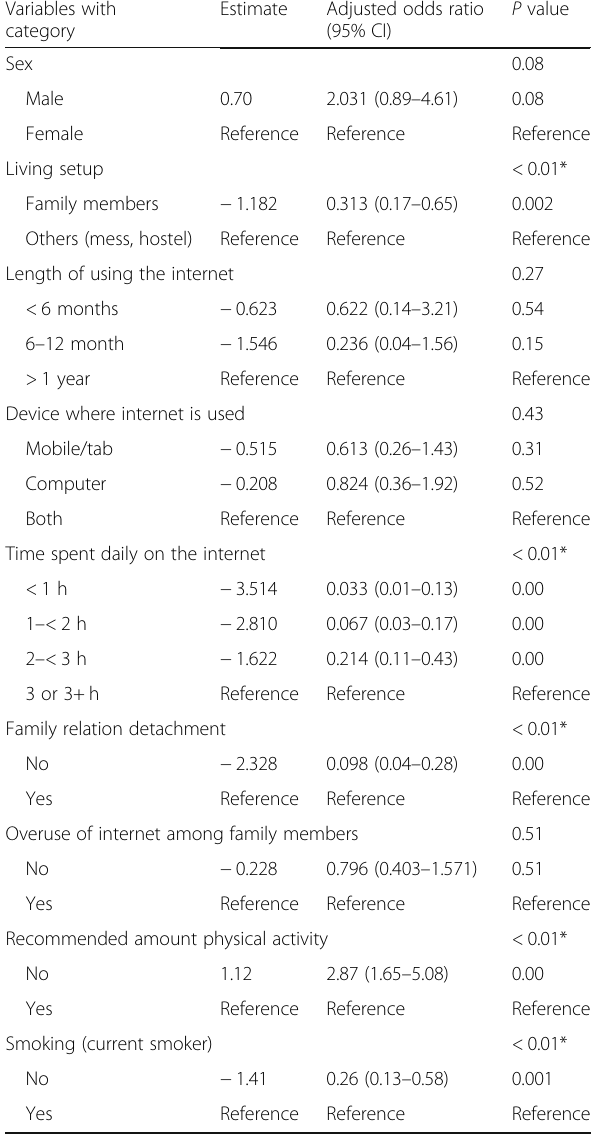
Table 4 Multiple logistic regression analysis of variables associated with internet addiction in